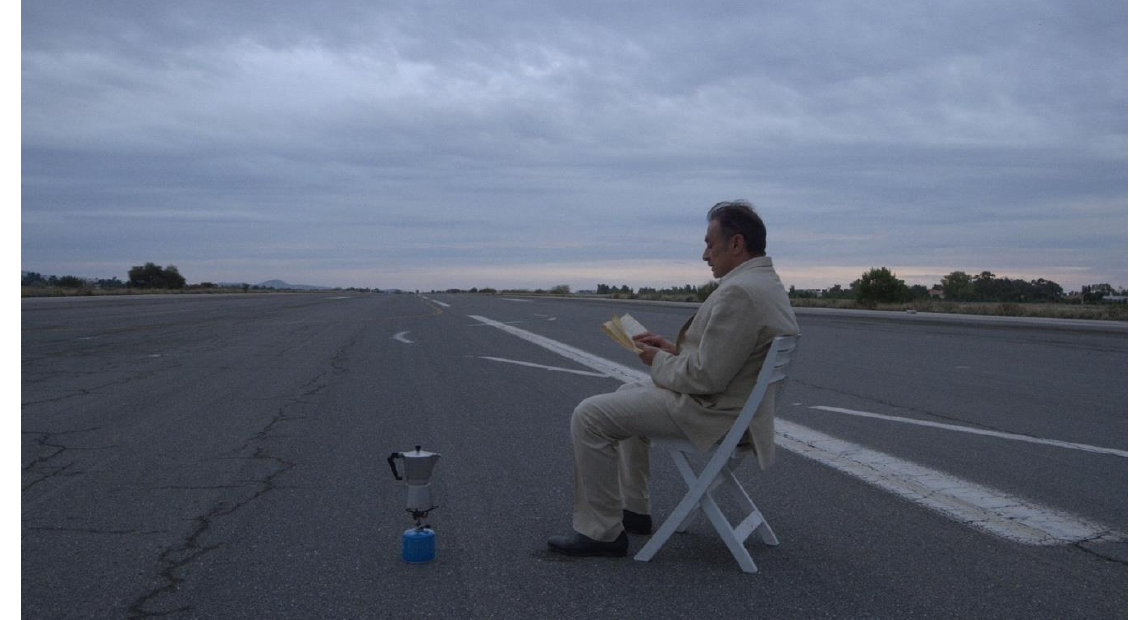
Figure 1. Naeem Mohaiemen, still from Tripoli Cancelled , 2017, digital video (color, sound), 95 min. © 2017 Naeem Mohaiemen. Courtesy of the artist and Experimenter, Kolkata.